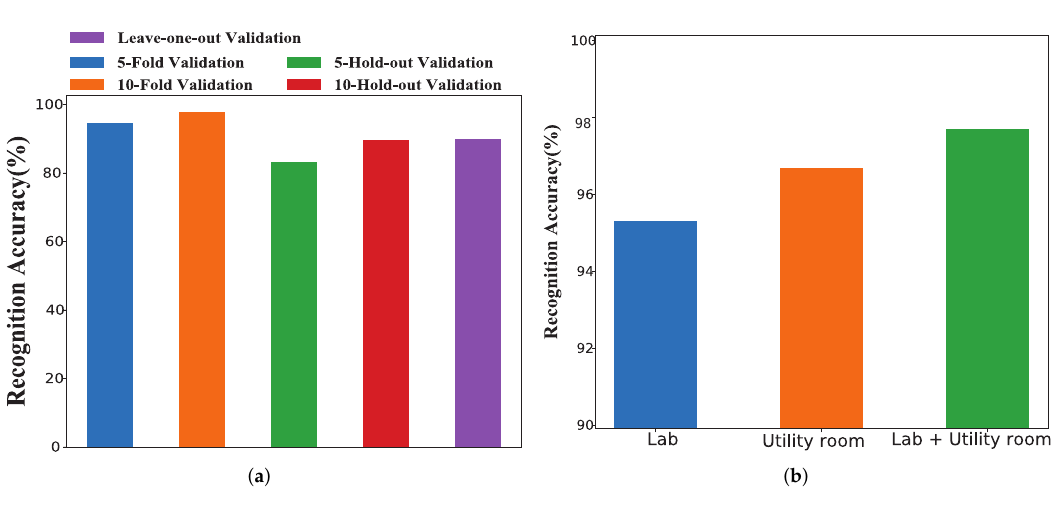
Figure 12. The accuracy of MCSM-Wri using different cross-validation methods and impact of experiment setting. ( a ) The accuracy of MCSM-Wri using 5-fold cross-validation, 10-fold cross-validation, 5-hold-out validation, 10-hold-out validation, and leave-one-out validation. ( b ) Impact of experiment